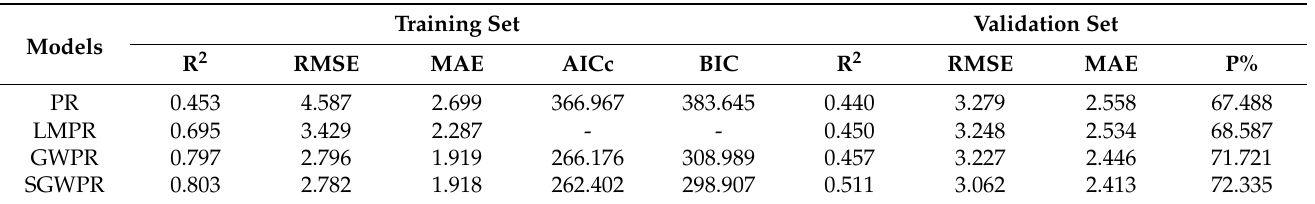
Table 5. Statistics of the evaluation indicators in the training and validation sets of the assessed global and local models.